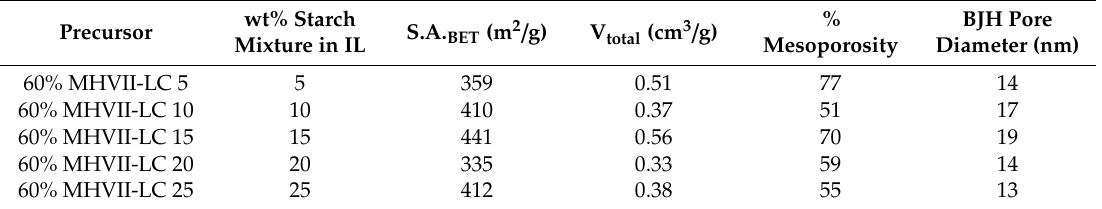
Table 5. Nanoporosity data of carbons obtained from Maize + Hylon VII (60 wt% amylose) prepared with the “low-cost” alternative route at 800 ◦